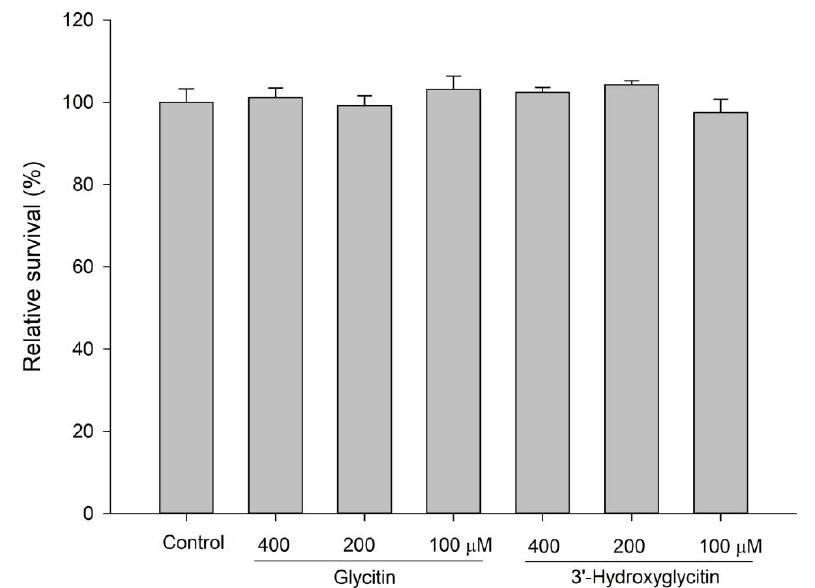
Figure 7. Cytotoxicity of glycitin and 3′-hydroxyglycitin on mouse B16 melanoma cells. The cells were seeded in 24-well plates for one day and then treated with various dosages of the tested drugs for another two days. Cell viability was then examined by an MTT assay. The mean ( n = 3) is shown, and the SD is represented by error bars.